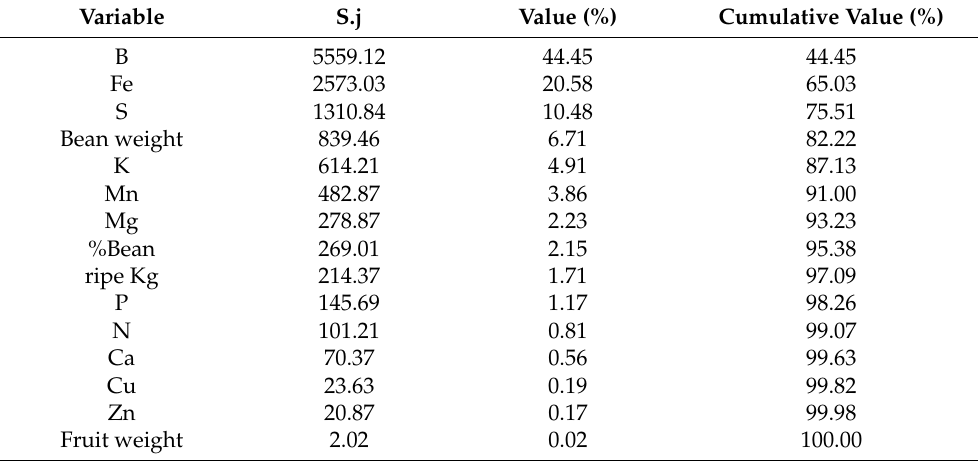
Table 3. Relative contribution of bean, husk, leaves, fruit characteristics, and nutrient concentration and accumulation in nine Coffea arabica L. cultivars grown in the mountain region of the Gorongosa National Park, Sofala, Mozambique, according to Singh’s method [41], based on the Mahalanobis generalized distance